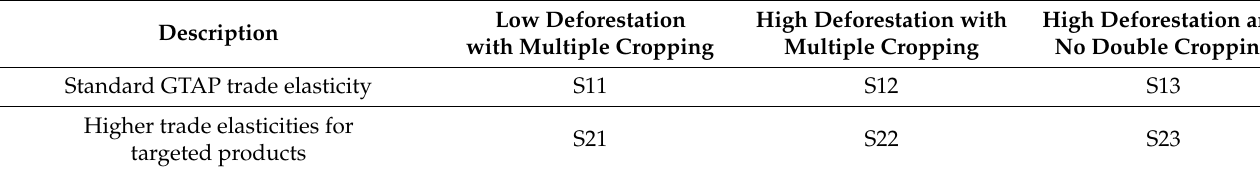
Table 1. Examined